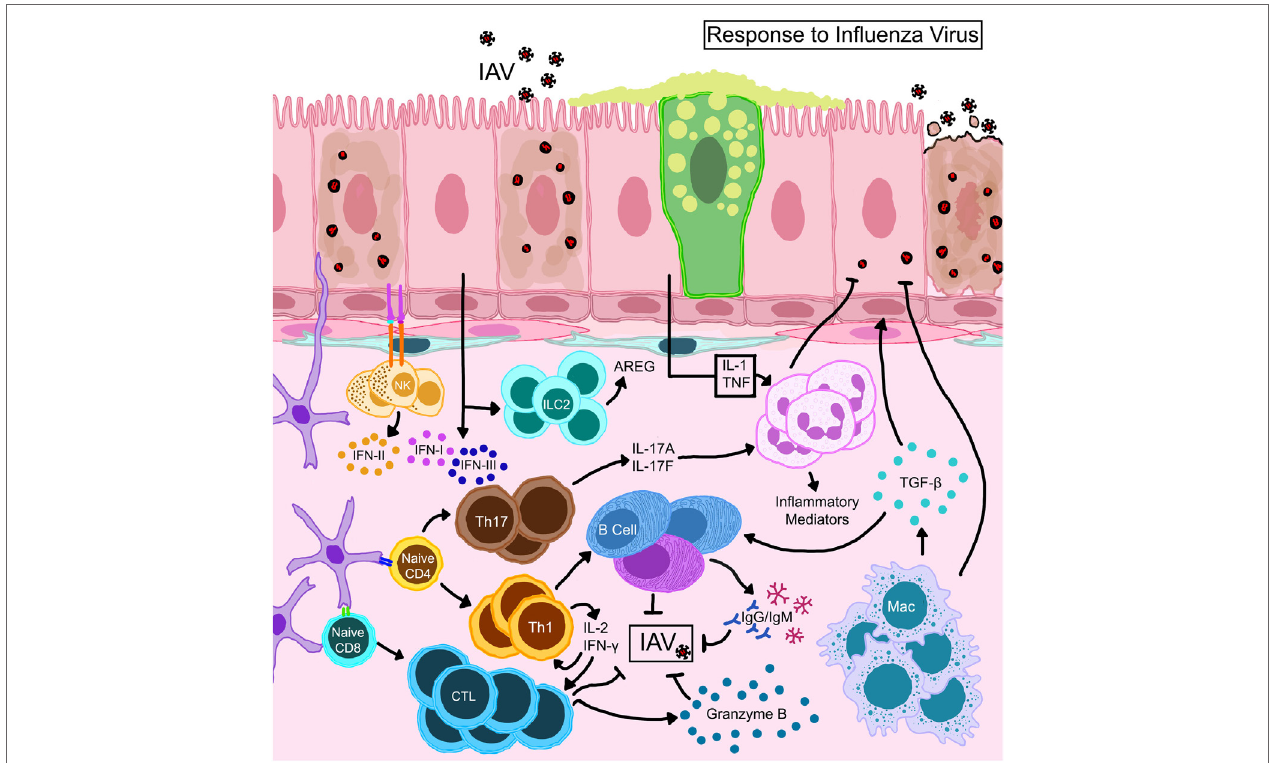
FiGURe 3 | Schematic representation of immune mechanisms activated during influenza A virus (IAV) infection. IAV hemagglutinin binds to sialic acid residues on epithelial cells triggering immune responses. Natural killer cells that complex with antigens expressed on epithelial cells become activated to release type II interferon (IFN). Activated dendritic cells expressing CD11b + CD103 + migrate to draining lymph nodes and prime T lymphocytes which differentiate into effector or memory cells. While CD8 + T cells directly kill virus-infected cells, CD4 + helper T cells direct the functions of resident/recruited cells through cytokine secretion. Transforming growth factor (TGF)- β produced by macrophages that are activated directly through TLR stimulation or indirectly by the local cytokine milieu and innate lymphoid cell (ILC)-driven amphiregulin (AREG) promote repair to the epithelial barrier. The damaged epithelial cells confer innate resistance by producing type I and type III interferons (IFNs) through stimulation of retinoic acid-inducible gene